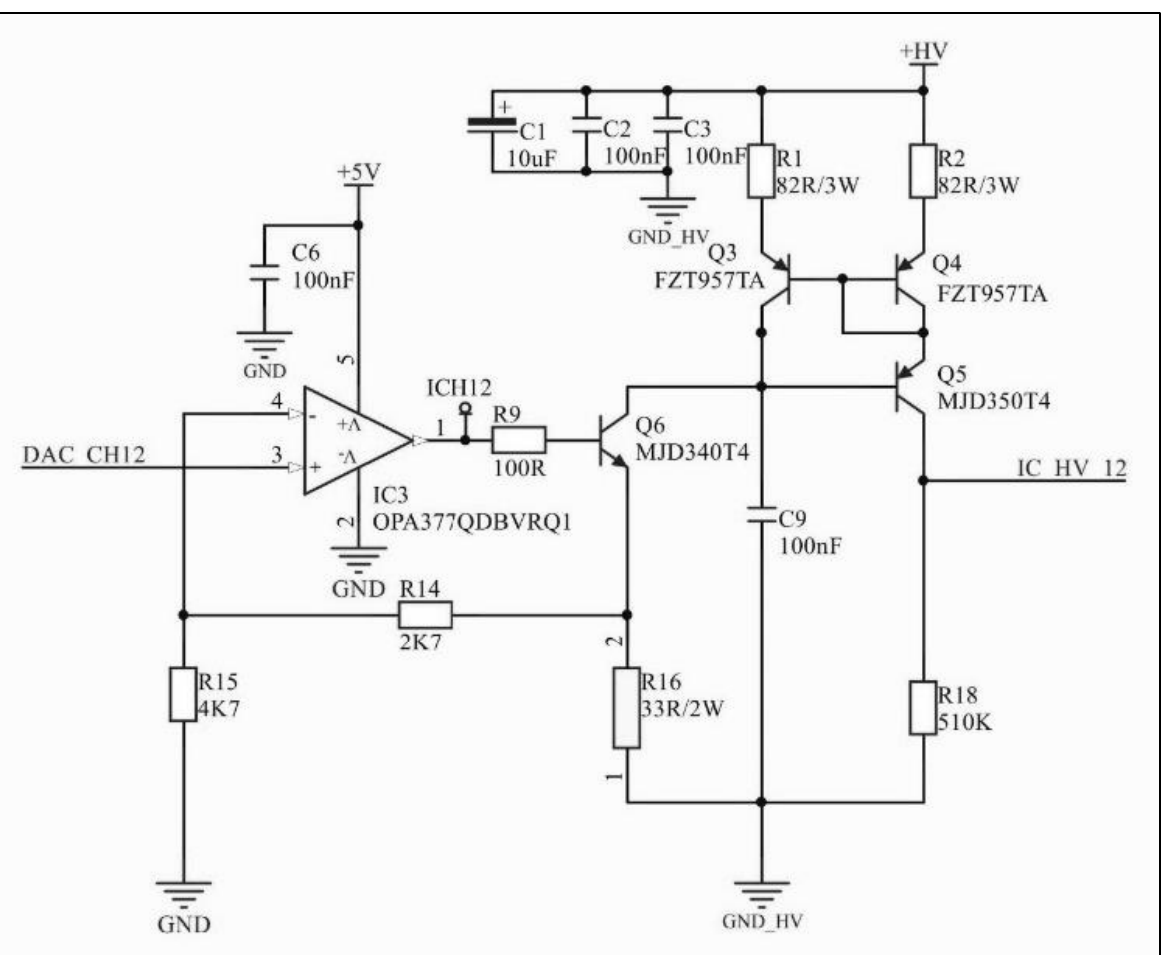
Figure 2. Voltage – current converter and Wilson current mirror. DAC_CH12 is the external DAC output voltage signal; the operational amplifier configuration in association with Q6 and R16 converts the voltage signal into a current signal; the Wilson current mirror controls the current amplitude to remain constant regardless of impedance variations.